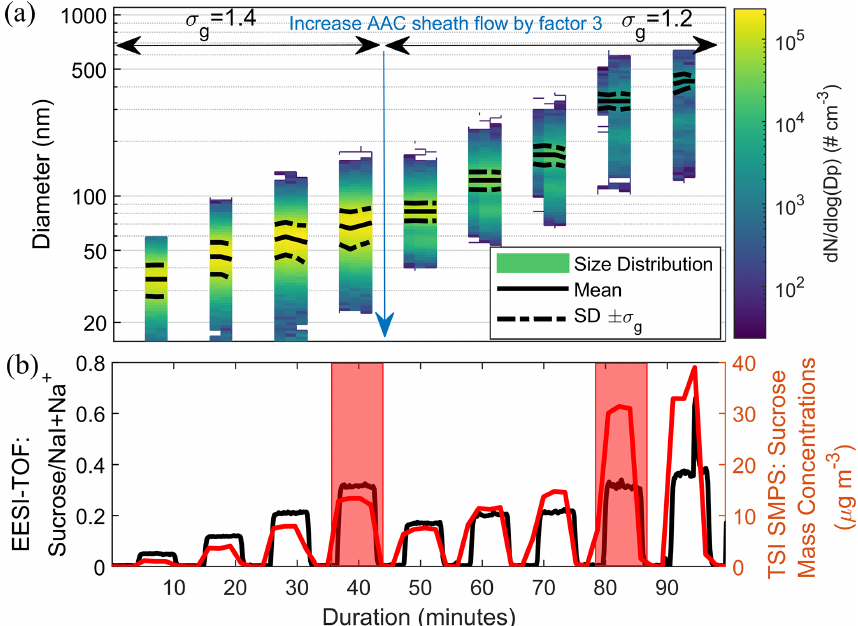
Figure 1. (a) Number-weighted size distribution of sucrose particles as measured by the SMPS after size selection using the AAC at two different settings of the AAC sheath flow. The solid and dashed black lines denote the geometric mean and ± 1 geometric standard deviation, σ g , of the number-weighted size distributions, respectively. The geometric standard deviation of the size-selected particle distribution of sucrose is lower at the higher sheath flow of the AAC as expected. Data points of particle counts lower than 1cm − 3 were removed. See Fig. S5 for the size-selection performance of the AAC as measured by the SMPS. (b) A representative EESI-TOF measurement that shows the time series of sucrose normalized to the [NaI + Na] + signal (most abundant ES ion) and the corresponding integrated particle mass concentration measured by the SMPS for size-selected sucrose particles (using the integrated volume concentration and a density of 1.59gcm − 3 ). Red windows indicate periods with the similar EESI signal intensity of sucrose but different particle size and mass